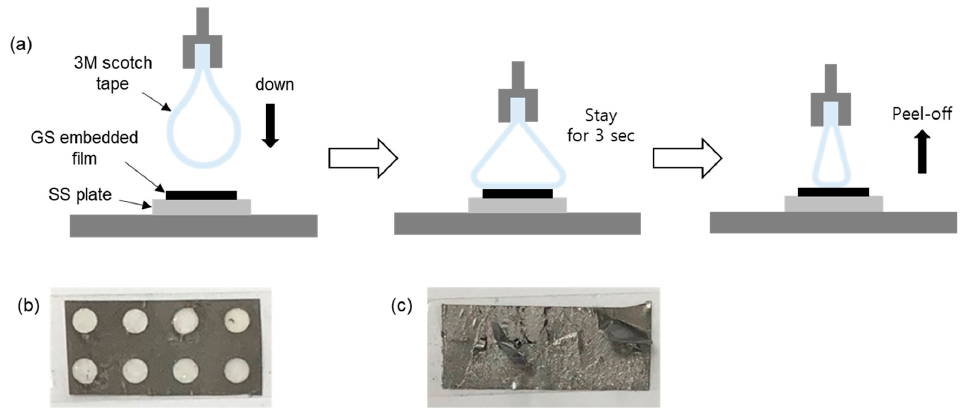
Figure 5. ( a ) Schematics for the tape testing method, and photos of the free-standing graphite film fabricated using ( b ) perforated and ( c ) non-perforated graphite sheet after the tape testing .